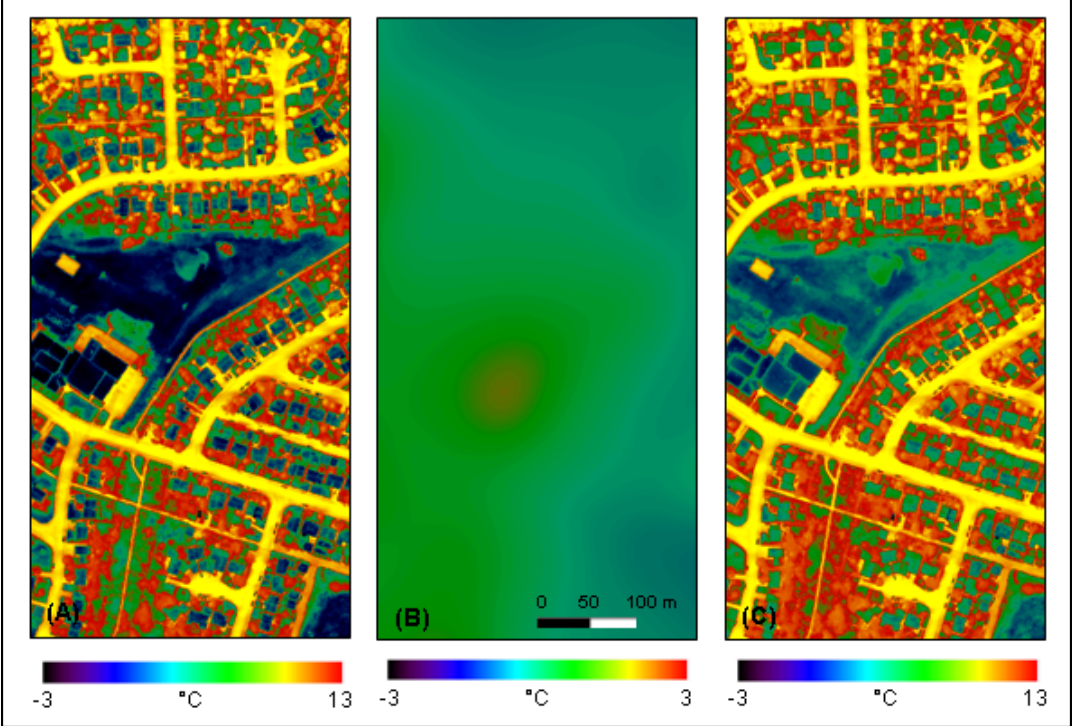
Figure 11. An example of radiometric normalization using TURN. ( A ) A portion of the raw TABI-1800 image. ( B ) A TURN-surface ( i.e. , an interpolated road temperature deviation surface ) of the same area. ( C ) An image of the same area after applying the